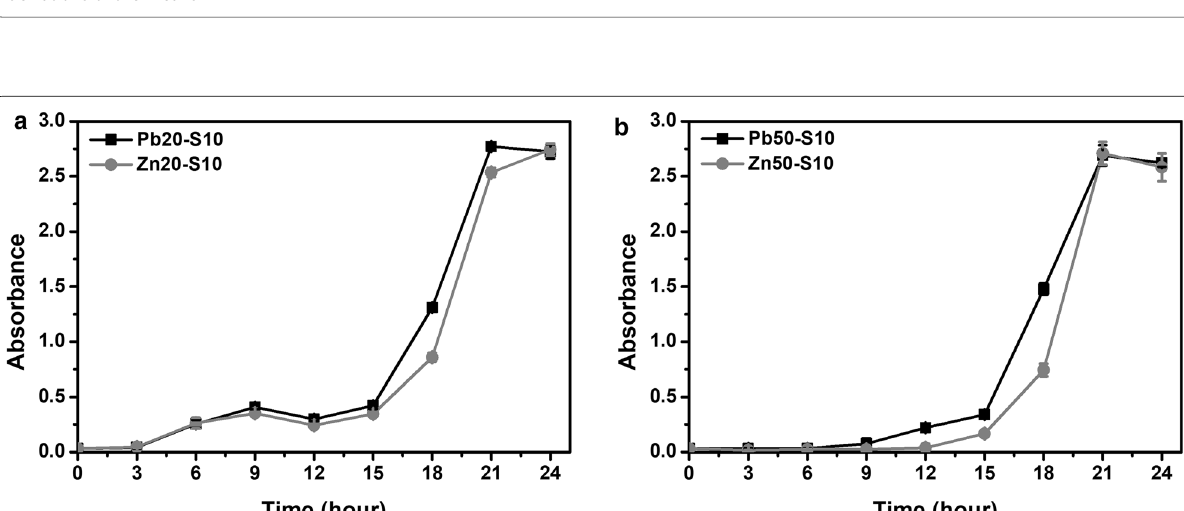
Fig. 4 Comparison of the growth curves of the chassis cells with the selection plasmid in response to lead and zinc in the presence of ampicillin. The optical density at 600 nm of the E. coli (pZE21-PBS) strain was measured with metal ions at a 20 µM and b 50 µM. Ampicillin was used at 100 µg mL − 1 . Squares: lead ions; Circles: zinc ions. Experiments were performed in triplicate, and data represent the averages and standard deviations of the means